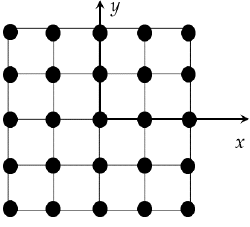
Figure 1. Planar antenna and Cartesian reference system x , y with origin in the center of the antenna. Black dots highlight the positions of antenna elements (x i , y j ).